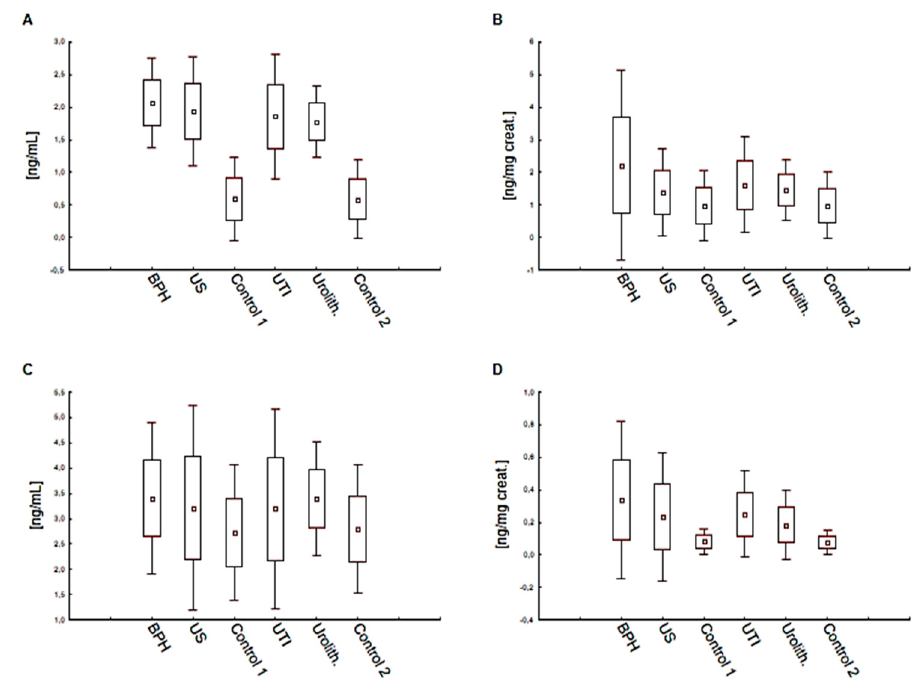
Figure 1. Mean values of concentrations, range of values and standard deviation of UPIIIa and UPII in the plasma and urine of patients with selected benign urological diseases and control groups C1 and C2: ( A ) UPIIIa (plasma); ( B ) UPIIIa (urine); ( C ) UPII (plasma); ( D ) UPII (urine).Abbreviations: